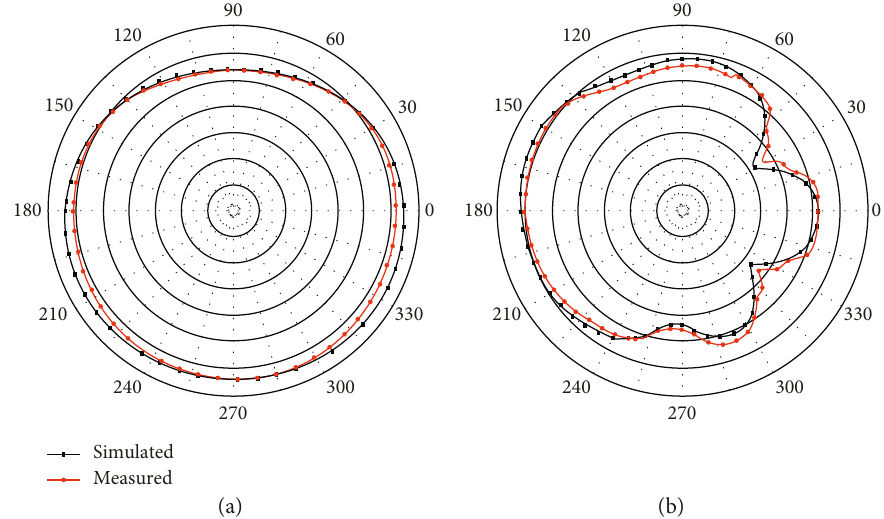
Figure 11: Measured gain for the 4-element MIMO antenna. (a) x-z plane and (b) x-y plane.